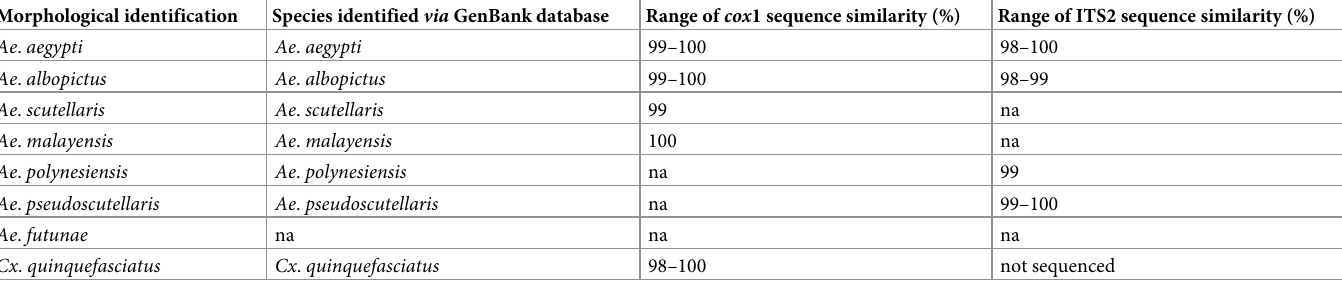
Table 2. Overview of mosquito identification by cox 1 and ITS2 molecular typing. Morphological